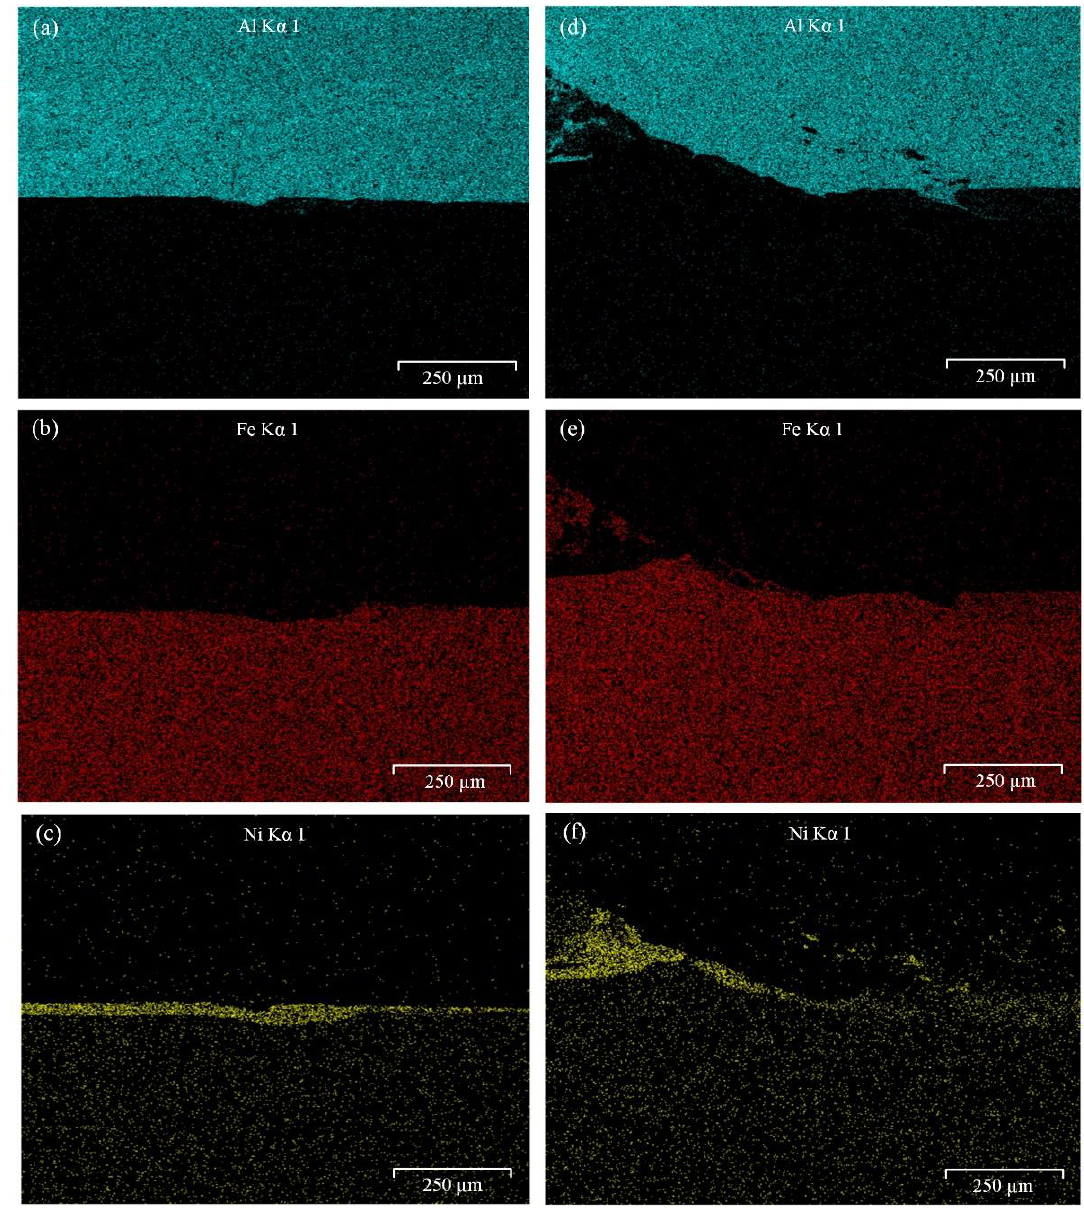
Figure 3. EDS analysis results of region A: ( a – c ) 800 rpm; ( d – f ) 1200 rpm.